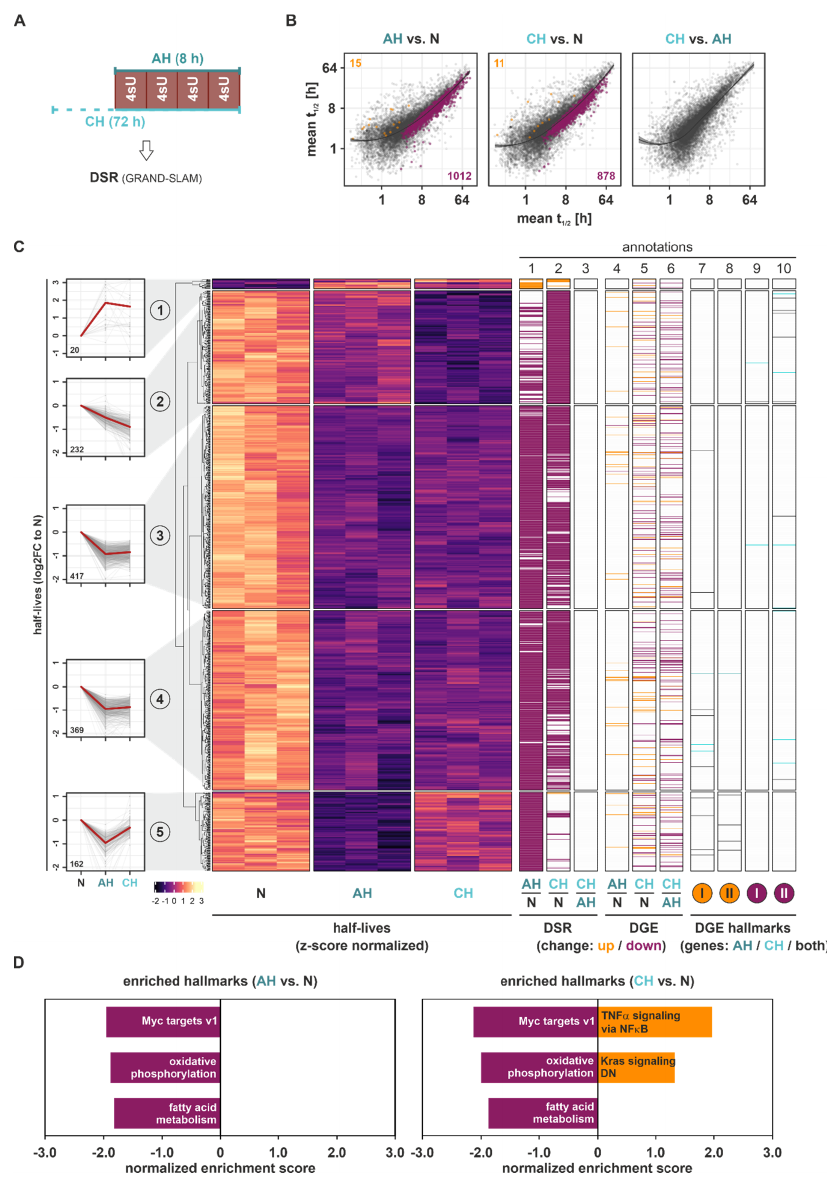
Figure 3. Differential stability regulation (DSR) changes under hypoxia. ( A ) THP-1 cells were incu- bated under hypoxia (1% oxygen) for 8 h (acute hypoxia, AH) or 72 h (chronic hypoxia, CH), or under normoxia, supplemented with 4 × 30 µ M 4-thiouridine (4sU) during the last 8 h. DSR changes were determined based on 4sU alkylation-dependent changes in T-to-C conversions using GRAND-SLAM. ( B ) Scatter plots comparing mean mRNA half-lives at AH vs. N ( left ), CH vs. N ( middle ), and CH vs. AH ( right ) highlighting significantly increased (orange) or decreased (purple) half-lives between the conditions (padj < 0.1, local linear regression + 95% confidence intervals). ( C ) Heatmap reflecting z -score-normalized half-lives of all DSR targets significantly altered in at least one of the comparisons. Five groups representing different DSR dynamics were identified by k -means clustering analysis ( left panels ). Annotation columns 1–3 contain DSR changes (up: orange; down: purple) for the comparison of AH and N, CH and N, and CH and AH. Annotation columns 4–6 encompass DGE changes (up: orange; down: purple) for the comparison of AH and N, CH and N, and CH and AH. Annotation columns 7–10 reflect targets contributing to the GSEA-enriched hallmarks either upregulated (I: hy- poxia; II: cholesterol homeostasis) or downregulated (I: Myc targets v2; II: E2F targets) in DGE of either AH, CH, or both (Figure 1D). ( D ) Top three enriched up- or downregulated hallmarks identified by GSEA of mRNA half-life changes under AH or CH relative to